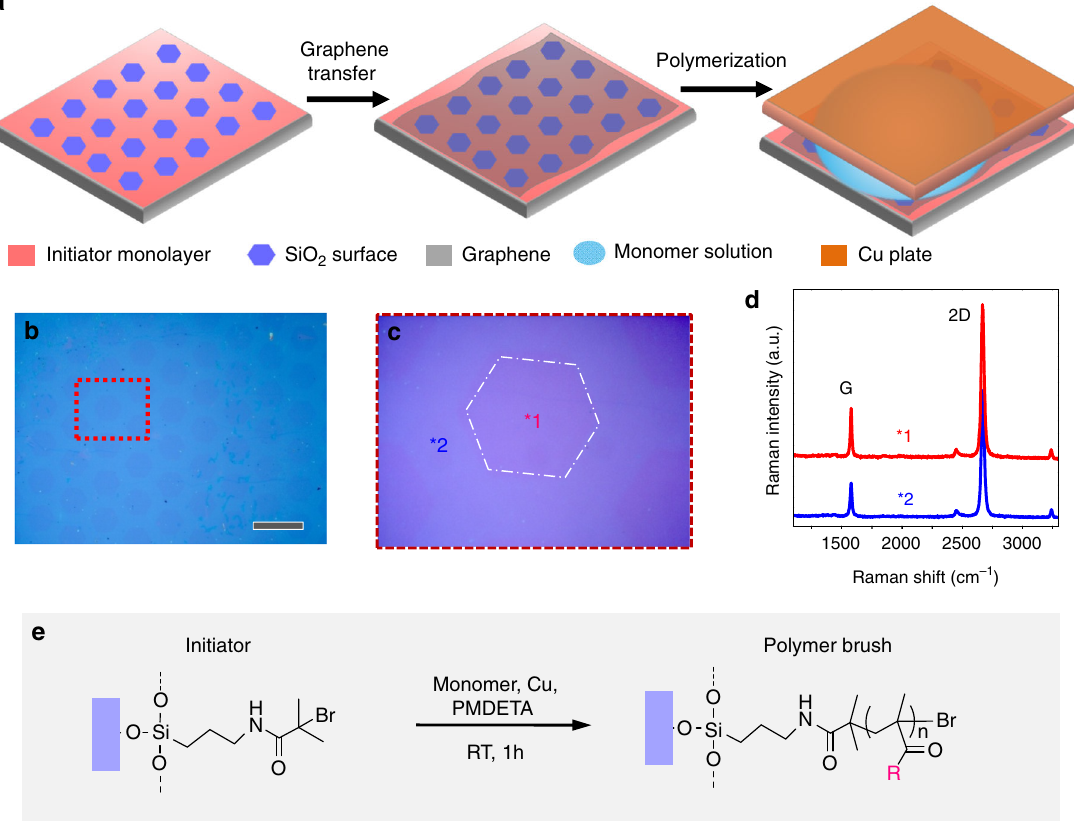
Fig. 2 Substrate preparation and characterization. a Schematic illustration of the preparation of substrate graphene-BiBB-SiO 2 and SI-CRP. b Optical image of graphene-BiBB-SiO 2 , scale bar: 40 µ m. c A close-up of selected area from b . d Typical Raman spectra are given for the two selected positions from c . e Reaction scheme of SI-CRP on graphene-BiBB-SiO